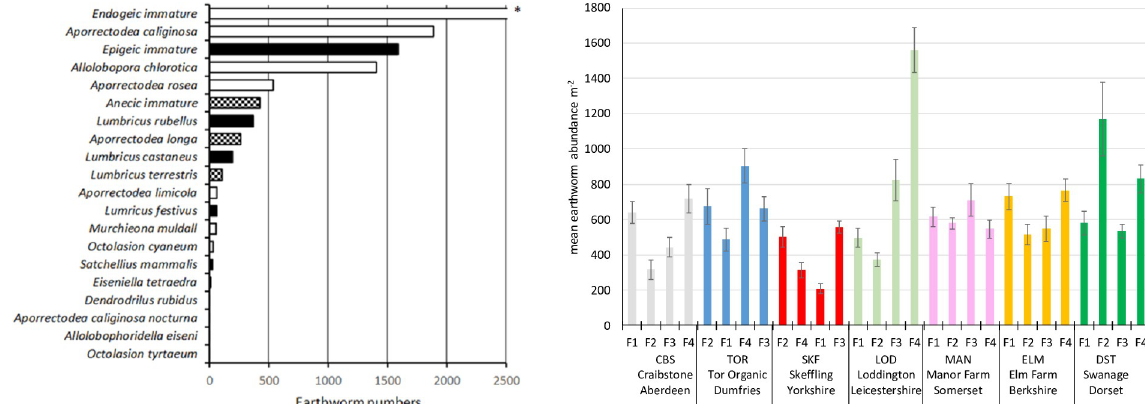
Fig 2. Abundances of earthworms by (a) species (total numbers). Total numbers = 13298 earthworms (endogeics = 77%, epigeics = 17%, anecics = 6%). � = continues to 6126 individuals; open bars indicates endogeic species, closed bars epigeics and checked bars anecics and (b) sampling site (mean abundance m -2 ± standard error, n = 15–20). F1 to F4 for each sampling site are fields 1 through 4 and for each farm are arranged in order from lowest management intensity on the left to highest intensity on the right. The intensity levels are relative and not necessarily comparable between